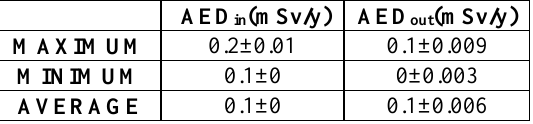
Table 1: Annual Effective Dose rate values of the sampled Sand in selected Bungoma County, Kenya